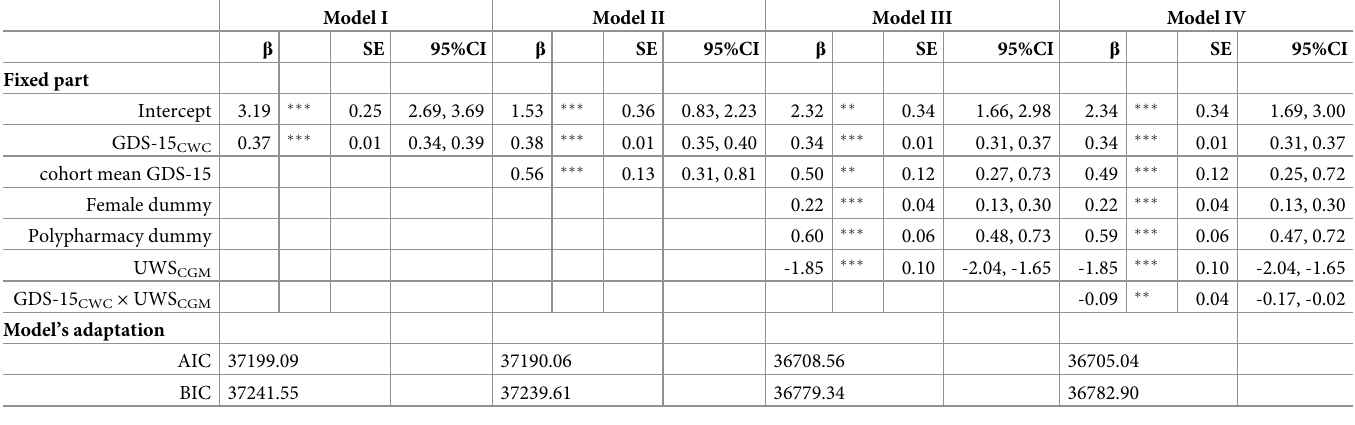
Table 6. Result of random intercept model with a dependent variable of KCL without depression score